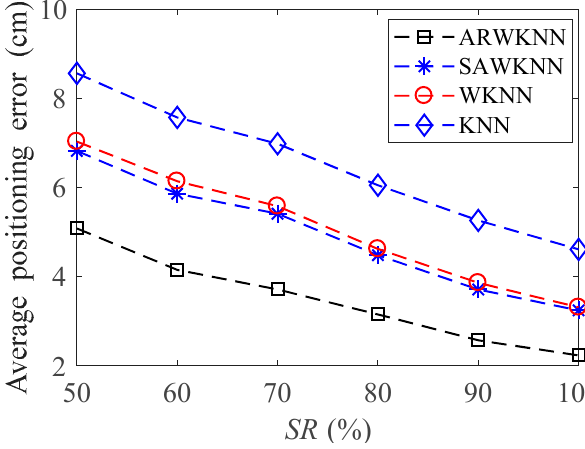
= 4. Sensors 2020 , 20 , x FOR PEER REVIEW max